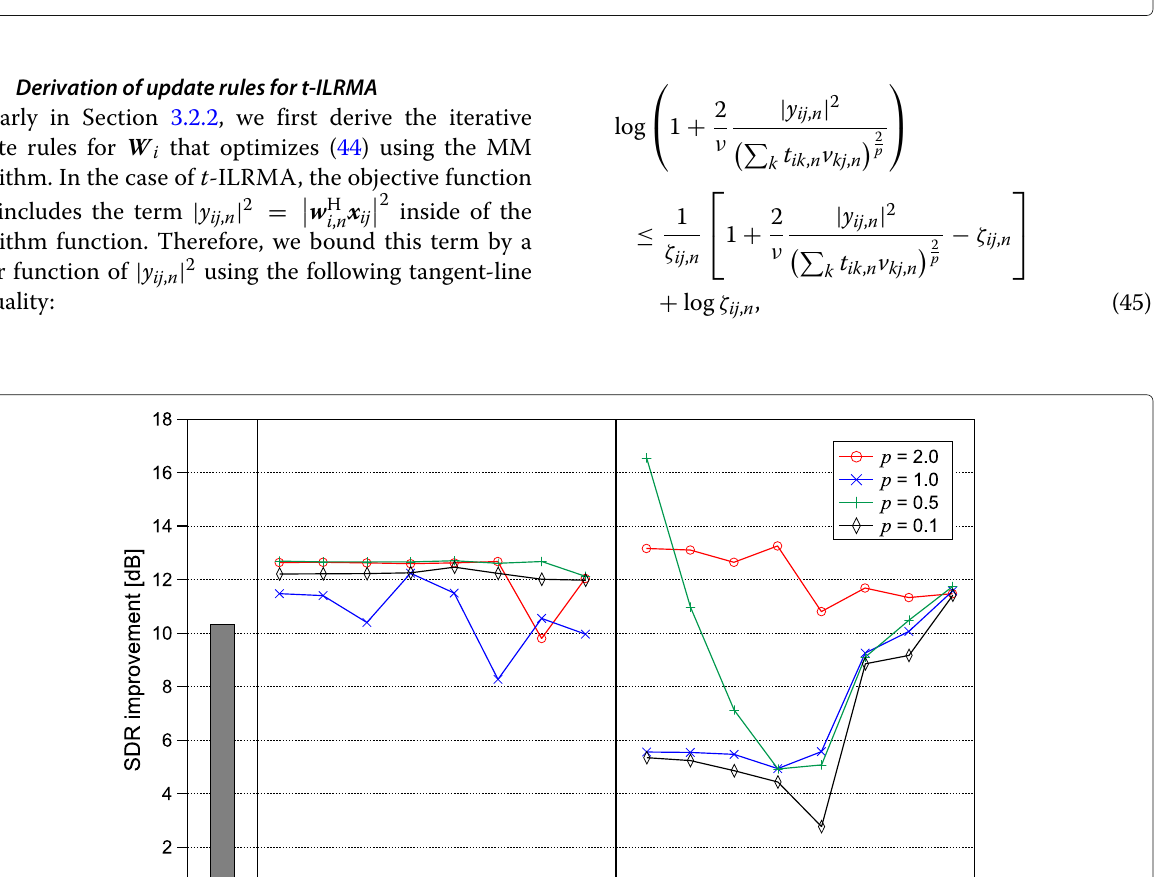
Fig. 16 Average SDR improvements of Music 1 with E2A_1 signal using parameter tempering